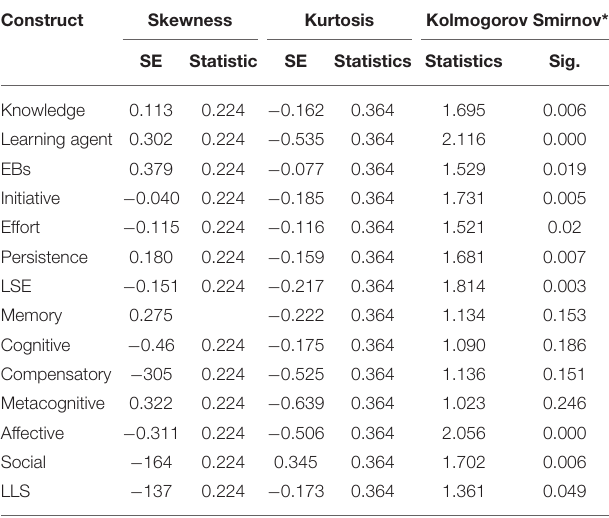
TABLE 2 | Skewness, kurtosis, and normality test for different variables.